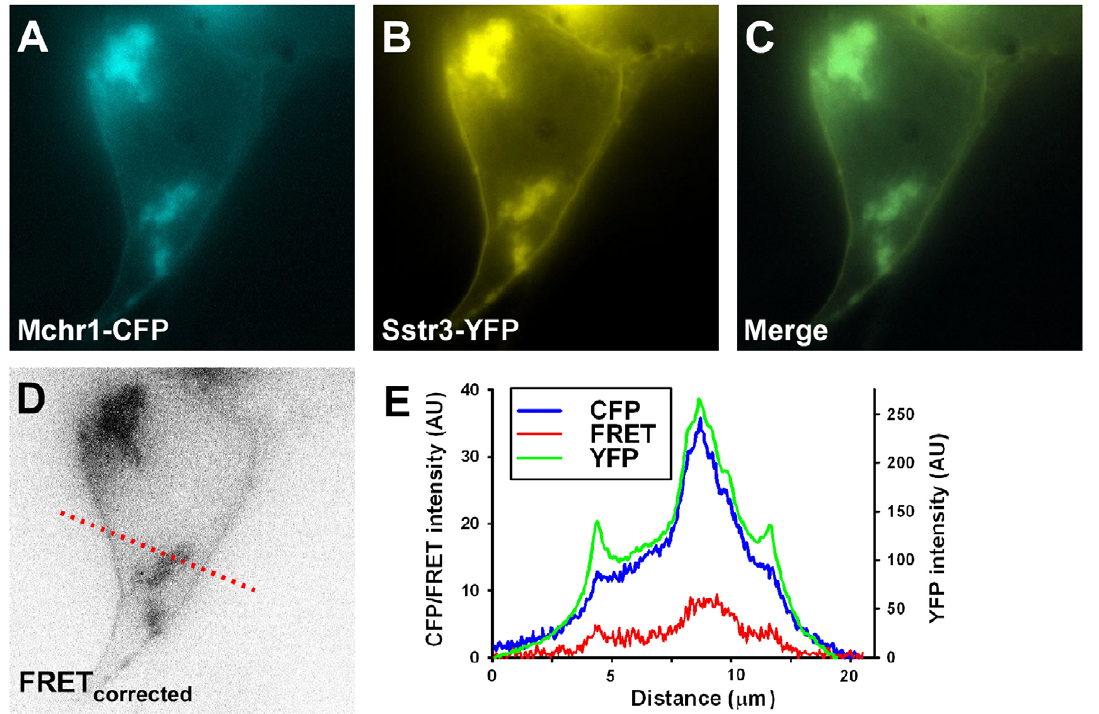
Figure 6. Mchr1 and Sstr3 interact in live cells. HEK293T cells were transiently co-transfected with constructs encoding CFP-tagged Mchr1 and YFP-tagged Sstr3. Mchr1-CFP and Sstr3-YFP colocalize at the plasma membrane and in intracellular compartments (A–C). Robust FRET signals are observed between Mchr1-CFP and Sstr3-YFP localizing in intracellular compartments and moderate FRET signals are observed between Mchr1-CFP and Sstr3-YFP localizing in the cell membrane (D). The fluorescence intensity profile along the red-dotted line within the FRET corrected image is shown (E). The intensity scale for CFP (blue) and FRET corrected (red) are on the left. The intensity scale for YFP (green) is on the right. AU=Arbitrary Unit.